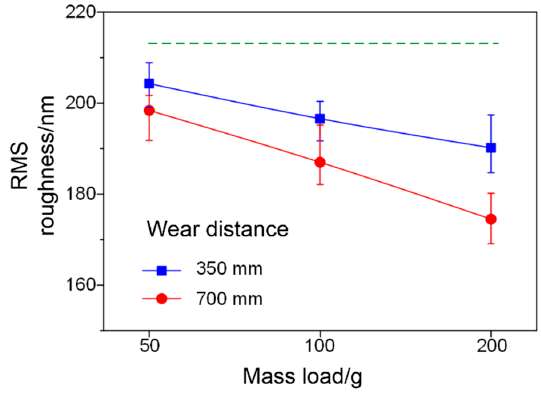
Figure 8. Root-mean-square (RMS) roughness of the worn super-hydrophobic coatings.